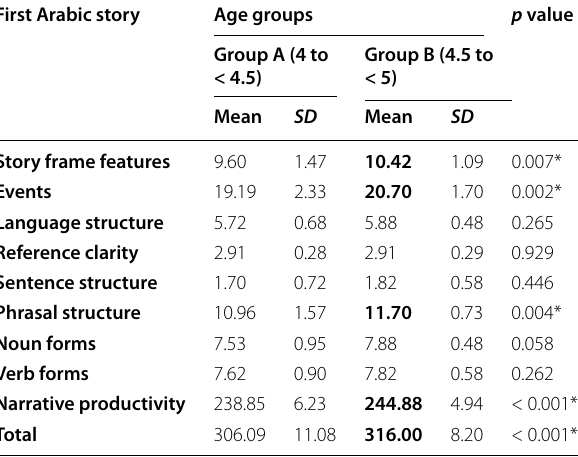
Table 4 Comparison between the scores of Arabic and English Semantic Test in age group A Group A (4 to < 4.5)